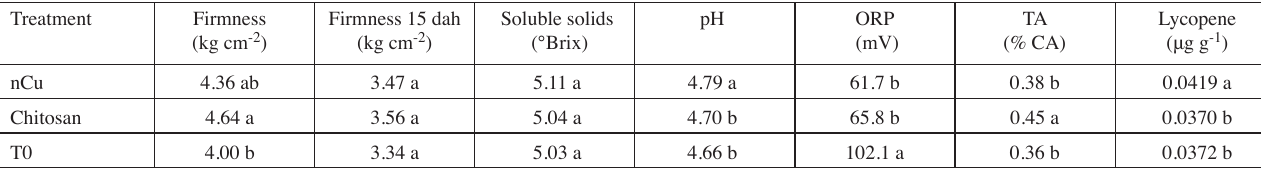
Treat: treatment. nCu: nCu-chitosan hydrogel at a concentration of 0.006 mg nCu L -1 . Chitosan: chitosan hydrogel without nCu. T0: absolute control without application of either chitosan hydrogel or nCu. CEA: catalase enzymatic activity (mM of H 2 O 2 min -1 total proteins [mg g -1 ]). SOD: superoxide dismutase (inhibition rate [%] of water soluble tetrazolium salt). GPX: Glutathione peroxidase (IU mg protein -1 ). Glu: glutathione (IU mg protein -1 ). APX: ascorbate peroxidase (μmol oxidized ascorbate min -1 mg -1 protein -1 ). TF: total phenols (mg Gallic Ac g -1 fresh tissue). Data is the mean of five samples. Different letters by column indicate significant differences among treatments, at P ≤ 0.05, according to the LSD test. Tab. 5: Fruit quality variables of tomato treated with nCu-chitosan hydrogel at a concentration of 0.006 mg nCu L -1 .